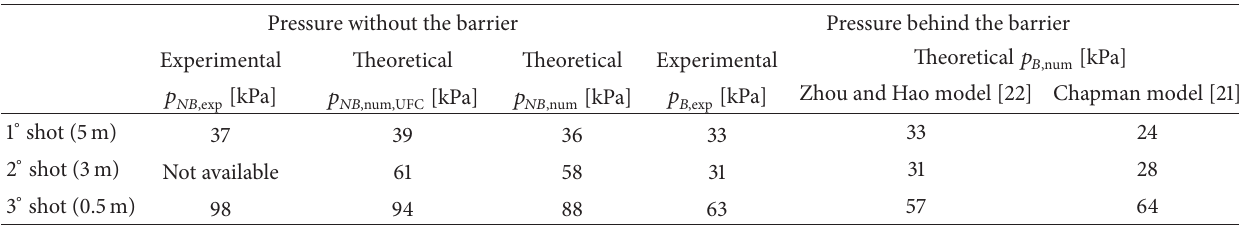
Table 3: Experimental and theoretical peak pressure.